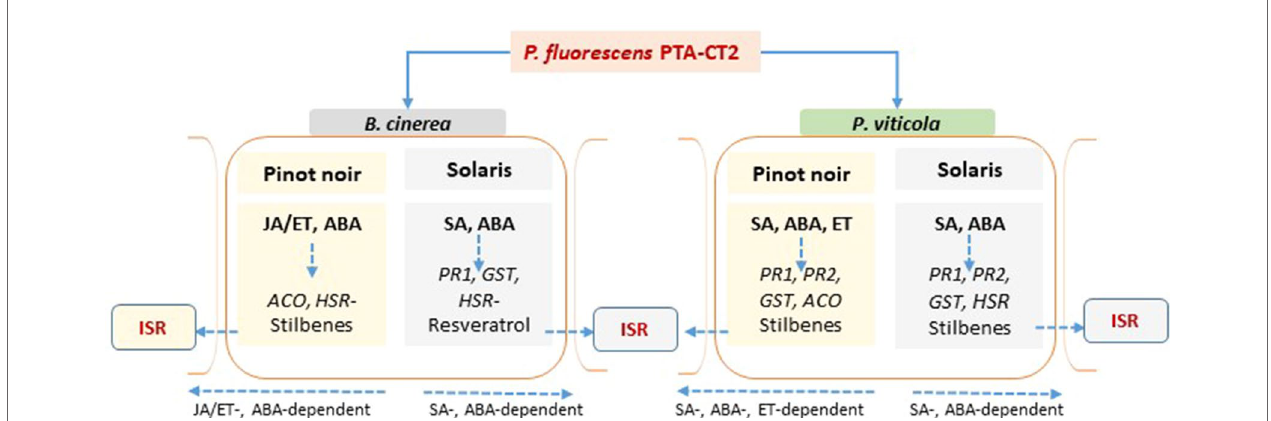
FIGURE 9 | Proposed model summarizing defensive pathways primed in Pseudomonas fluorescens -induced systemic resistance against Botrytis cinerea and Plasmopara viticola in the susceptible Pinot noir and the partially resistant Solaris grapevine genotypes. The phytohormones are in bold, the genes are in italic, and the sign (−) in front of the HSR gene means downregulated